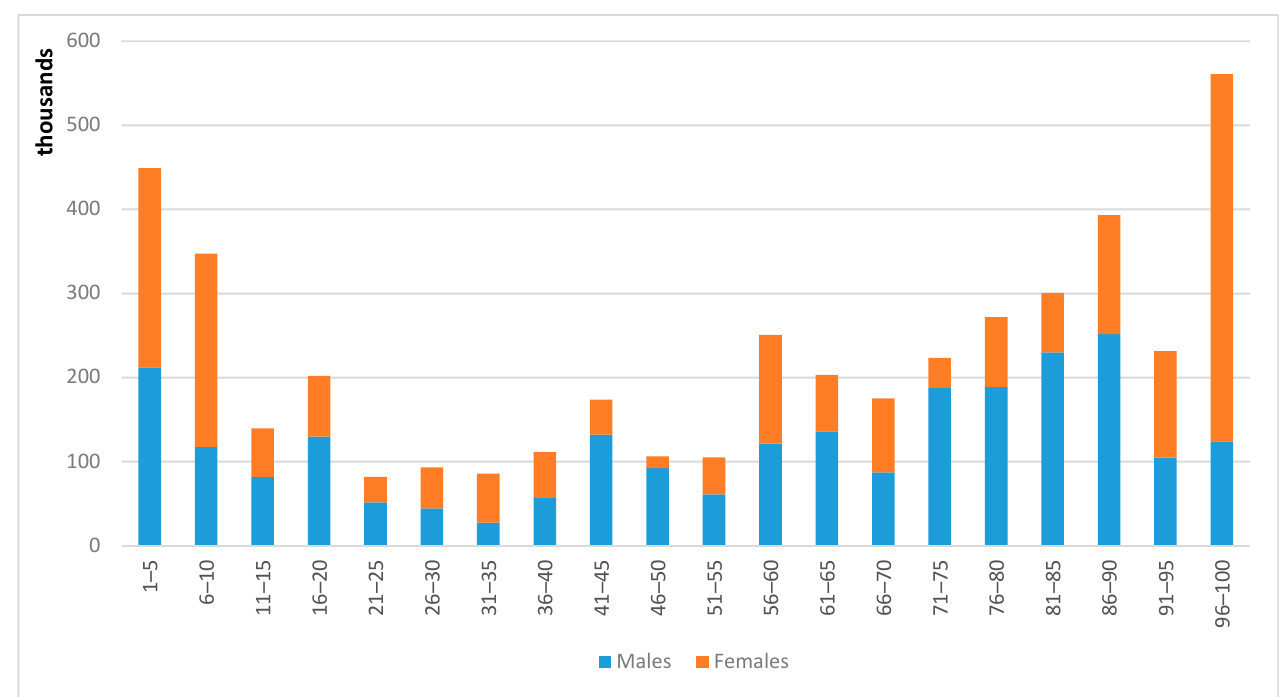
Figure 3. Breakdown of employees by susceptibility to automation and gender per person in 2016. Source: Microcensus 2016.